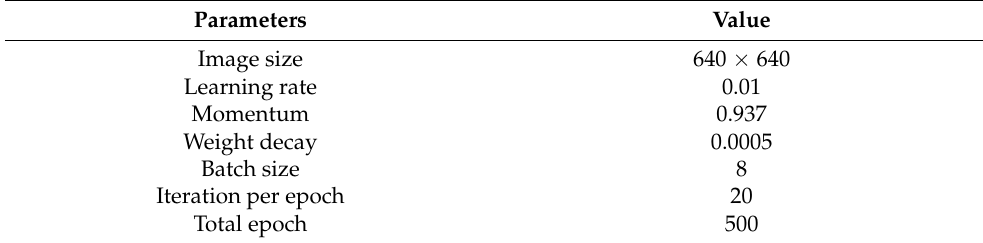
Table 2. Parameters of